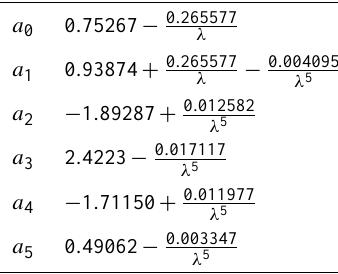
Table 2. Table of solar limb darkening parameters valid for 0 . 422 < λ [ µm ] < 1 . 1.